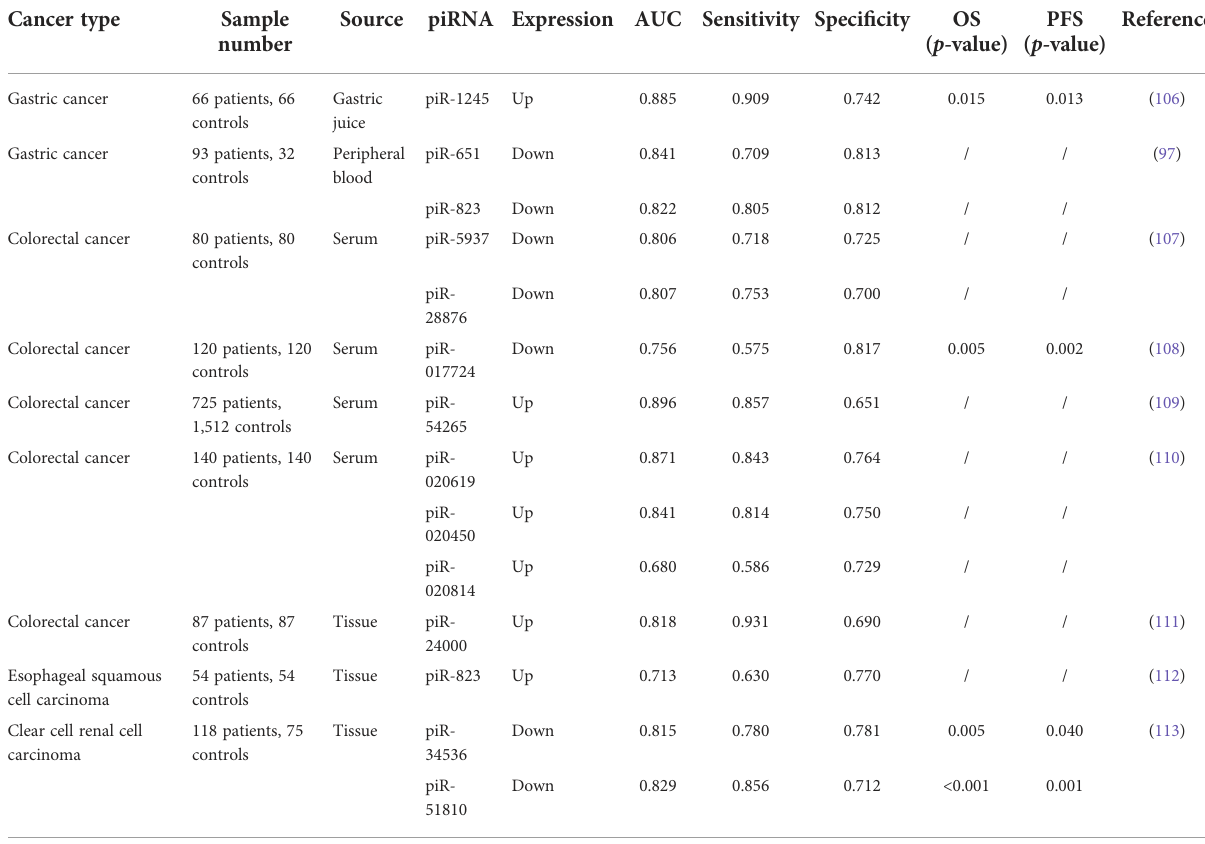
TABLE 1 piRNAs as diagnostic or prognostic biomarkers in clinical